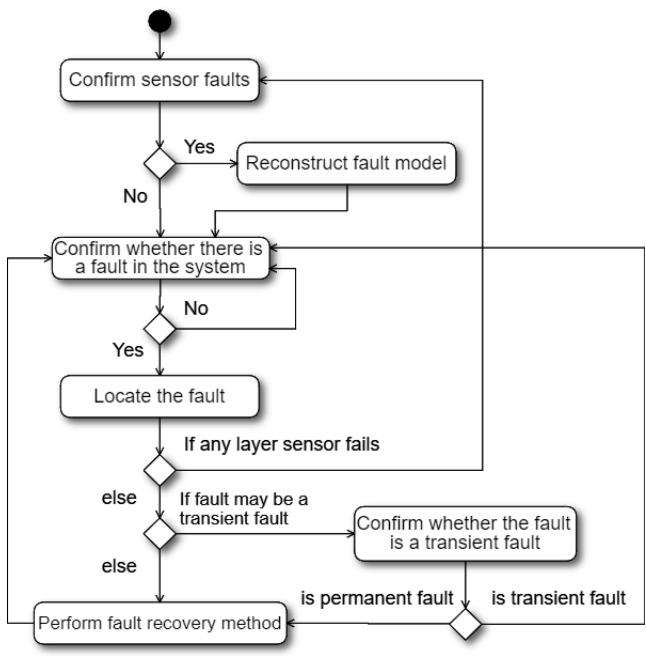
Figure 3. Flow chart of the proposed high-availability